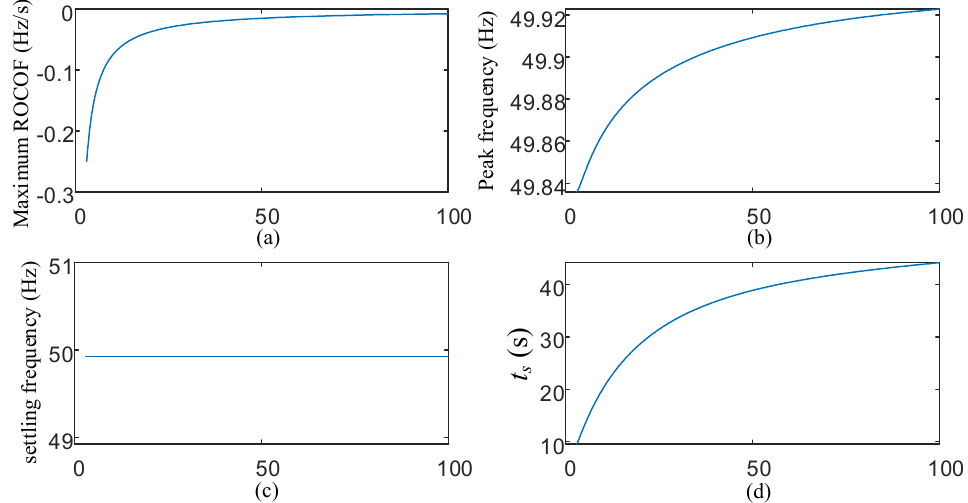
Figure 4. Inertia constant influence on performance indices: ( a ) maximum ROCOF, ( b ) peak frequency, ( c ) settling frequency, and ( d ) settling time.